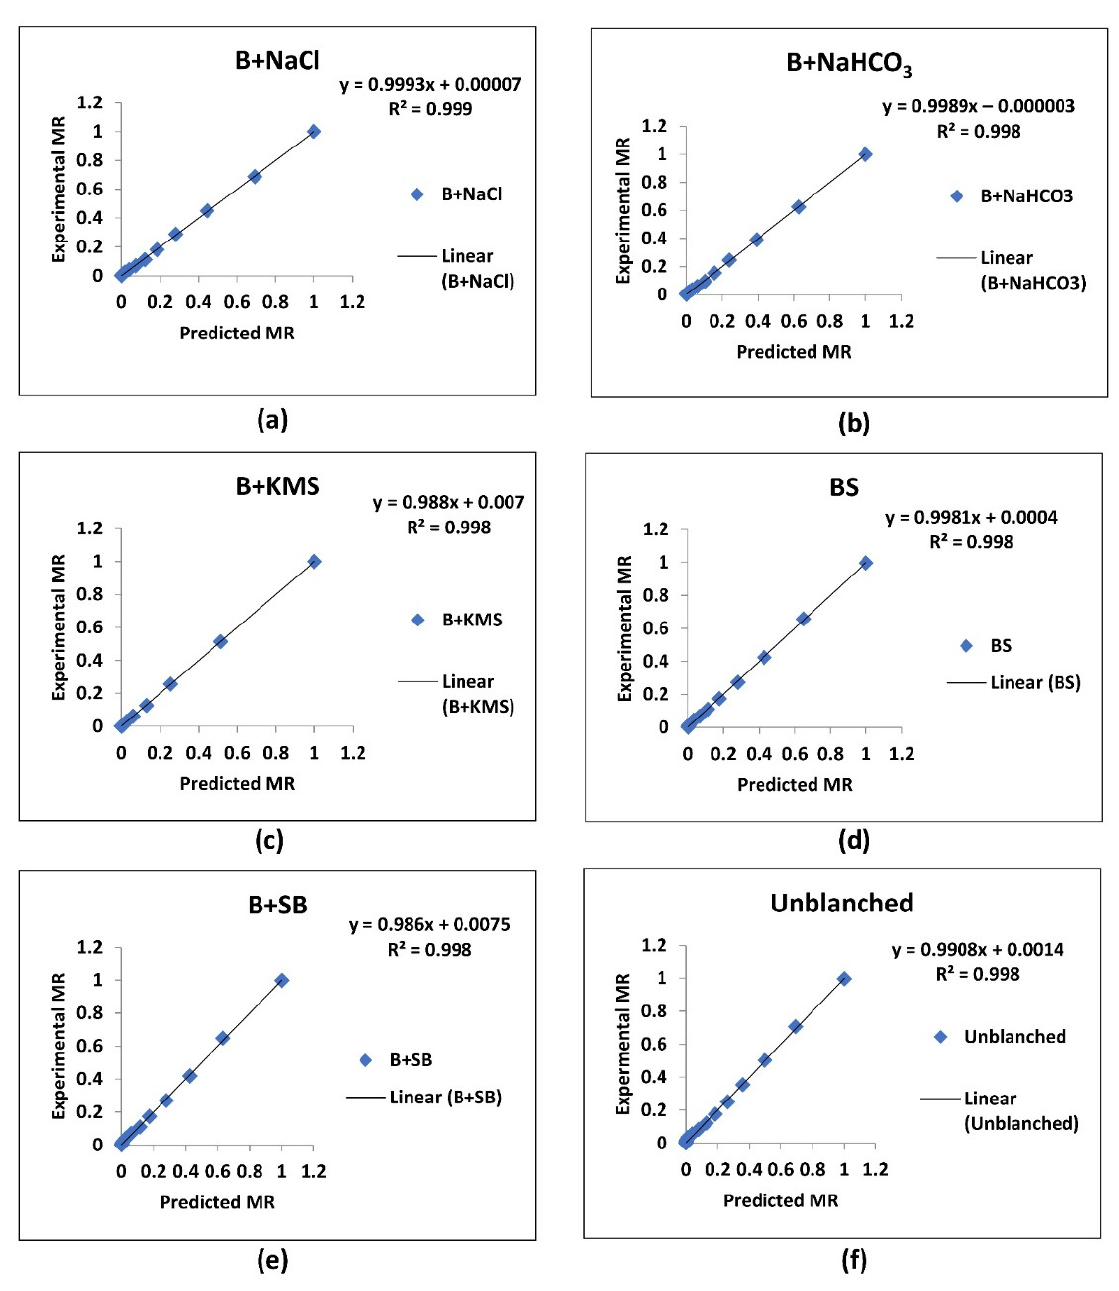
Figure 3. ( a – f ): Plot of experimental moisture ratio against predicted moisture ratio of pretreated and unblanched Moringa leaves at 50 °C using Midilli–Kucuk model for fluidized bed drying.